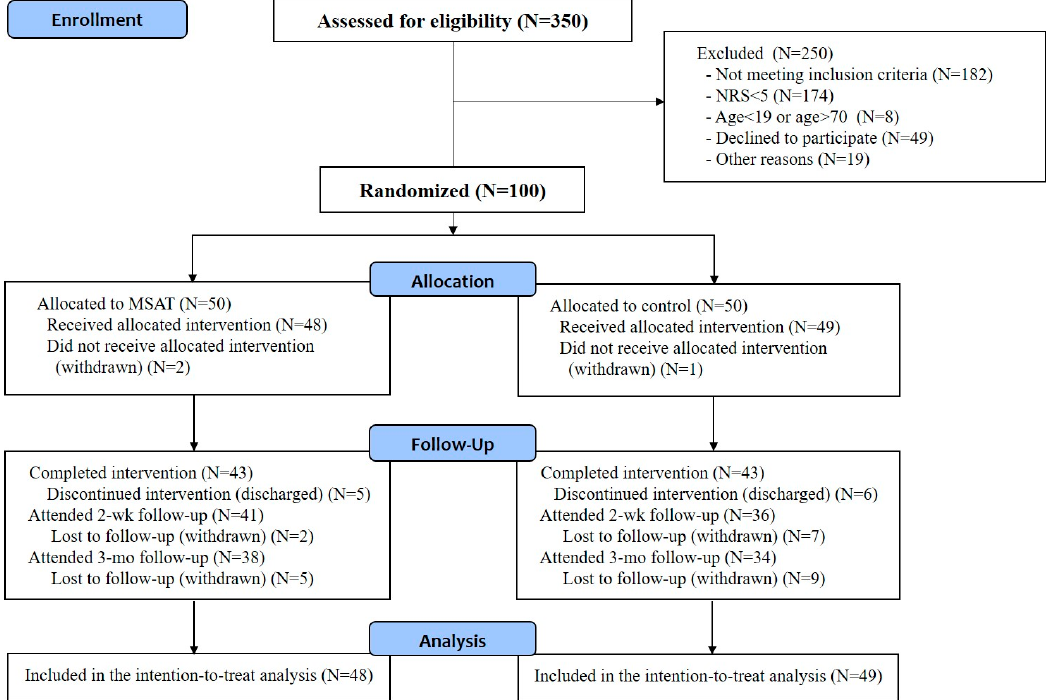
Figure 1. Flow chart of the participant enrollment process.